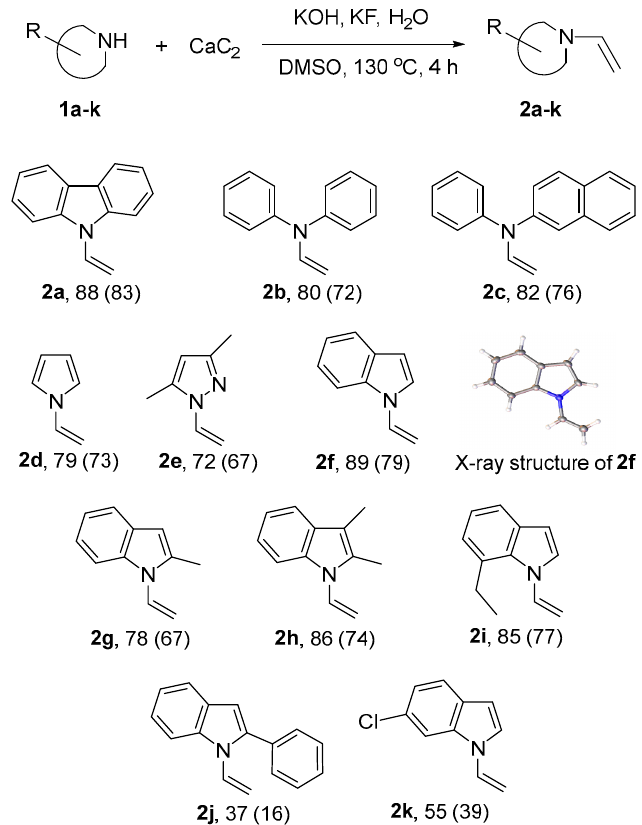
Scheme 3. Structures of vinylated secondary amine products and yields (in %). Reaction yields are given without parentheses, isolated yields are given in parentheses.